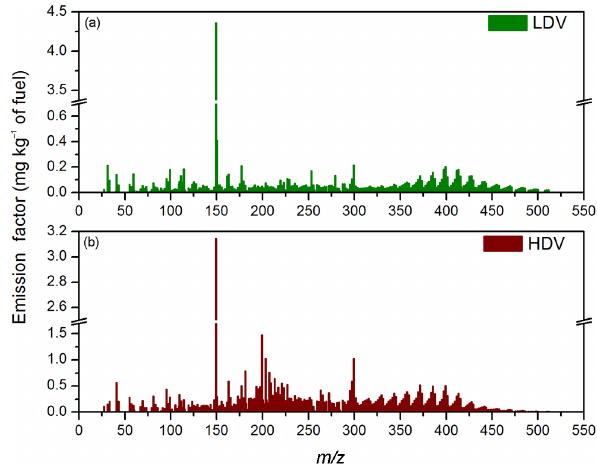
Figure 3. Average EFs (mgkg − 1 of fuel burned) mass spectra iden- tified by the TD-PTR-MS for (a) LDVs and (b) HDVs.